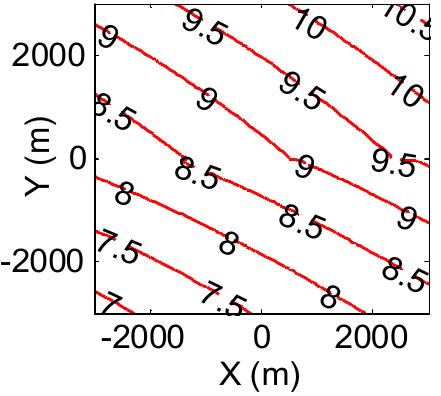
Figure 8. Azimuth resolution contour result for TOPS CF-SAR.